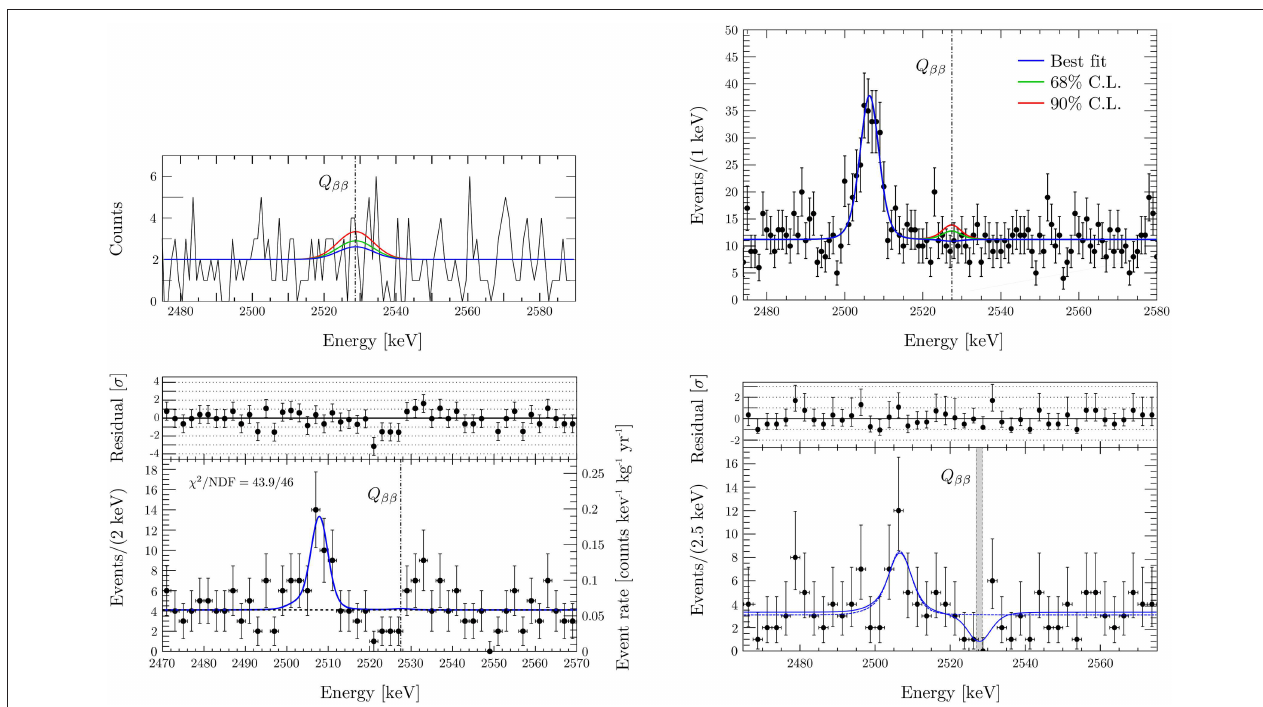
FIGURE 6 | (From Left to Right, Top to Bottom) MiDBD, Cuoricino, CUORE-0 and CUORE (first data release) best-fit model in the ROI region. No peak is found at Q ββ (that at 2507keV is attributed to 60 Co). Figures from Arnaboldi et al. [ 64], with permission from Elsevier, Alfonso et al. [67], with permission from Elsevier, ∼ Andreotti et al. [68], with permission from the American Physical Society, and Alduino et al. [69], with permission from the American Physical Society (see the references for